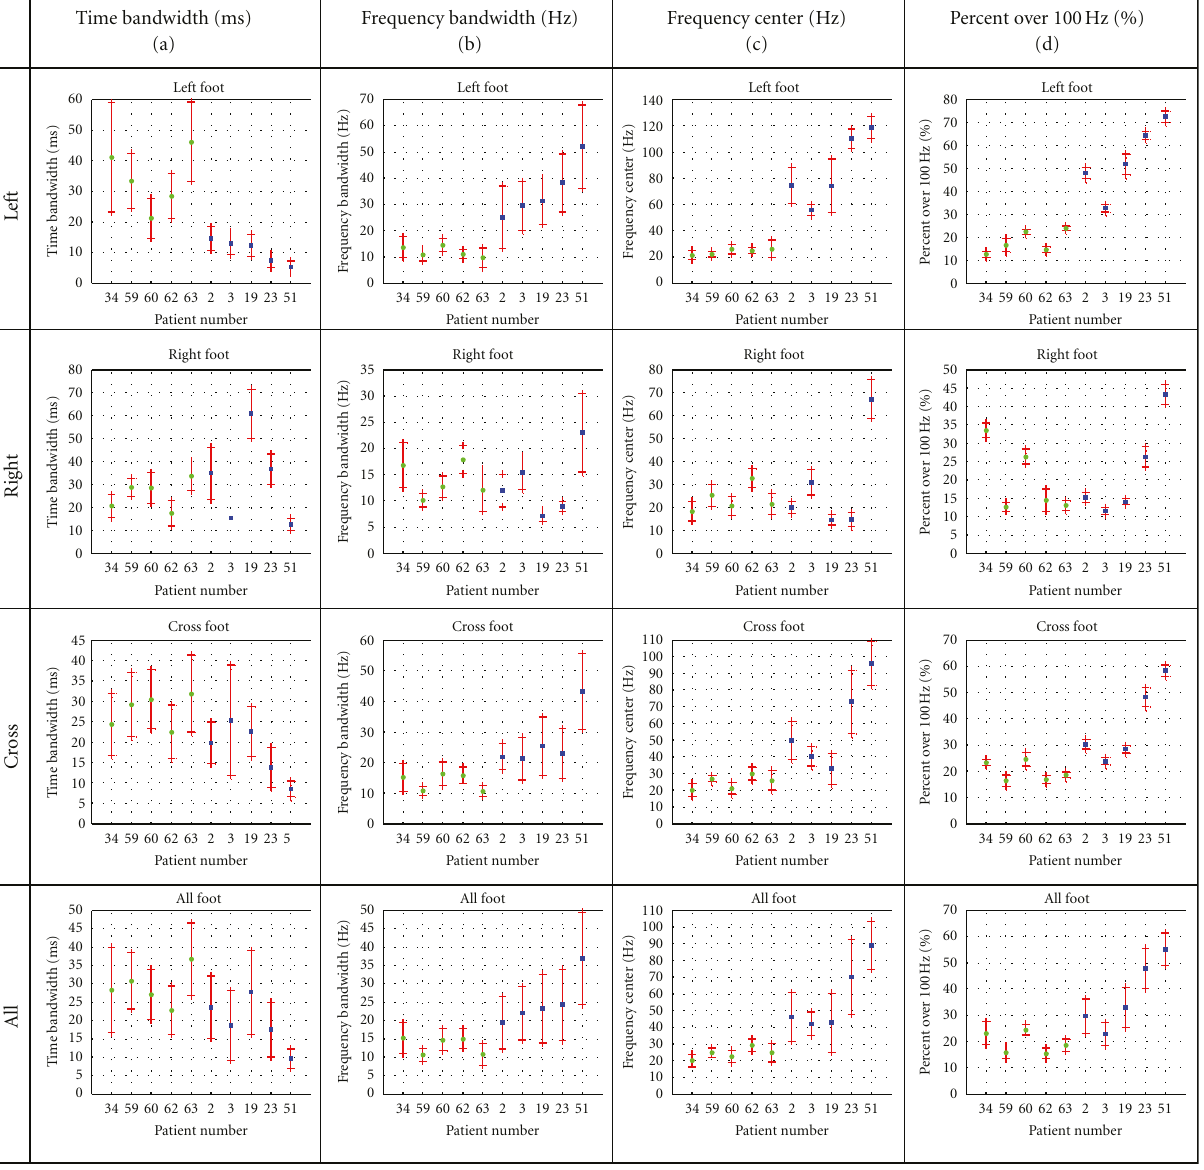
Figure 11: Means of cross-foot SDM for (a) time bandwidth, (b) frequency bandwidth, (c) frequency center, and (d) percent of energy above 100Hz; Mean values shown for control subjects are shown in green mean values for hypertensive cases are shown in blue standard deviations are shown on either side by red